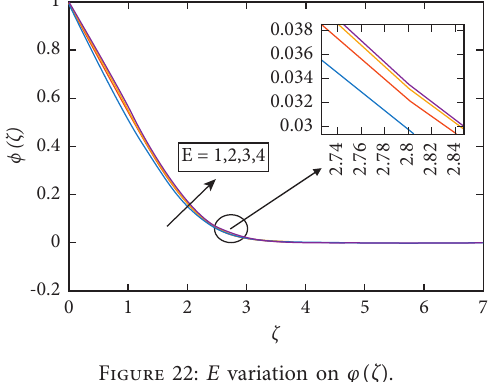
Figure 22: E variation on φ ( ζ ) . 0 . 5 fx Re x at selected values